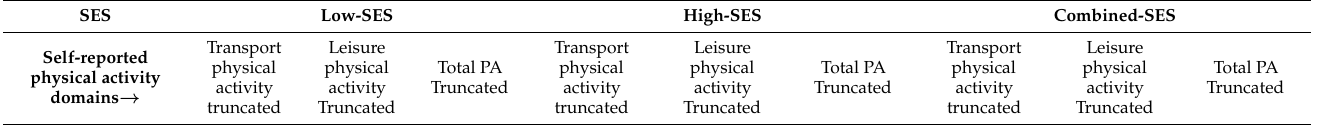
Table 2. GIS-measured walkability and self-report physical activity in the 1000 m